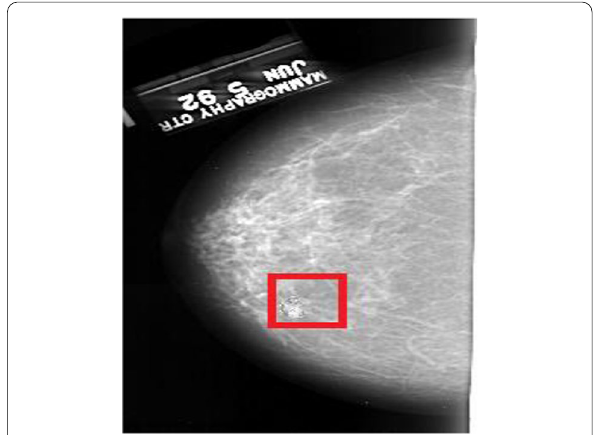
Fig. 1 An example of a correct CAD trial in which the target was present. Here the CAD cue highlighted the presence of a cancer. In present, incorrect CAD trials the cancer appeared outside of the CAD cue and in present, no CAD trials a cancer was present but no CAD cue was